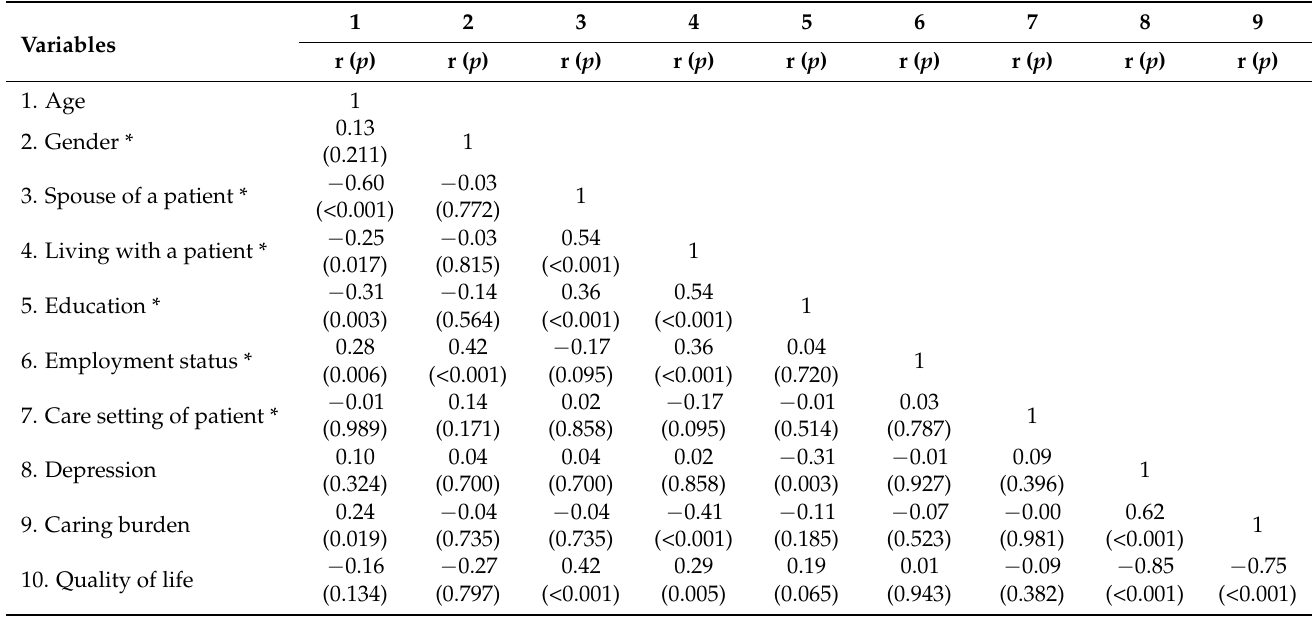
Table 2. Bivariate correlations between study variables.